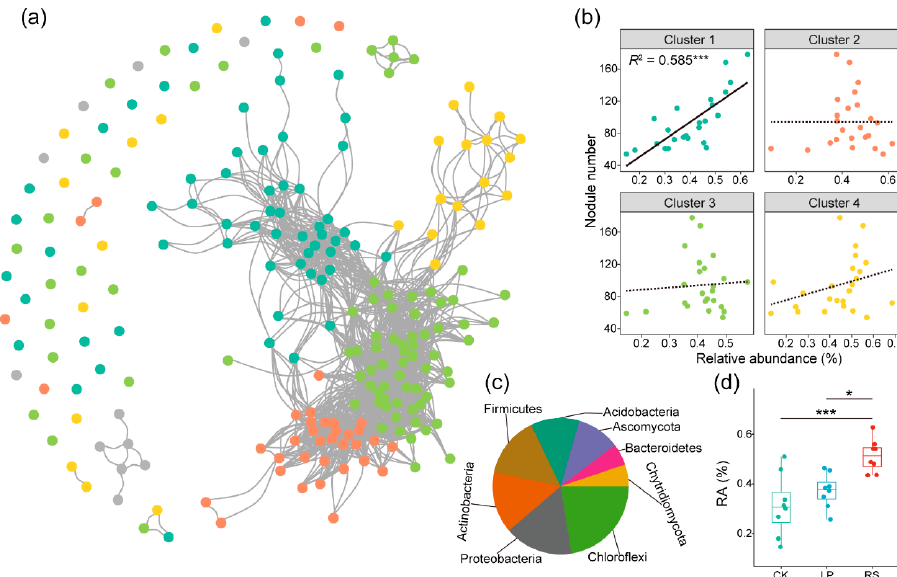
Figure 4. Correlation between key ecological clusters and nodulation ability of peanut. ( a ) The weighted gene correlation network analysis (WGCNA) of core microbiota. The color of the nodes indicates various ecological clusters. Each node in the figure represents an OTU. ( b ) The regressions between peanut nodule number and microbial eigentaxa weighted correlation network modules (statistically significant differences using ordinary least squares regression). ( c ) Composition of core Cluster 1 microbiota at the phylum level. ( d ) Relative abundance of Cluster 1 in different treatments (* p < 0.05; *** p < 0.001).